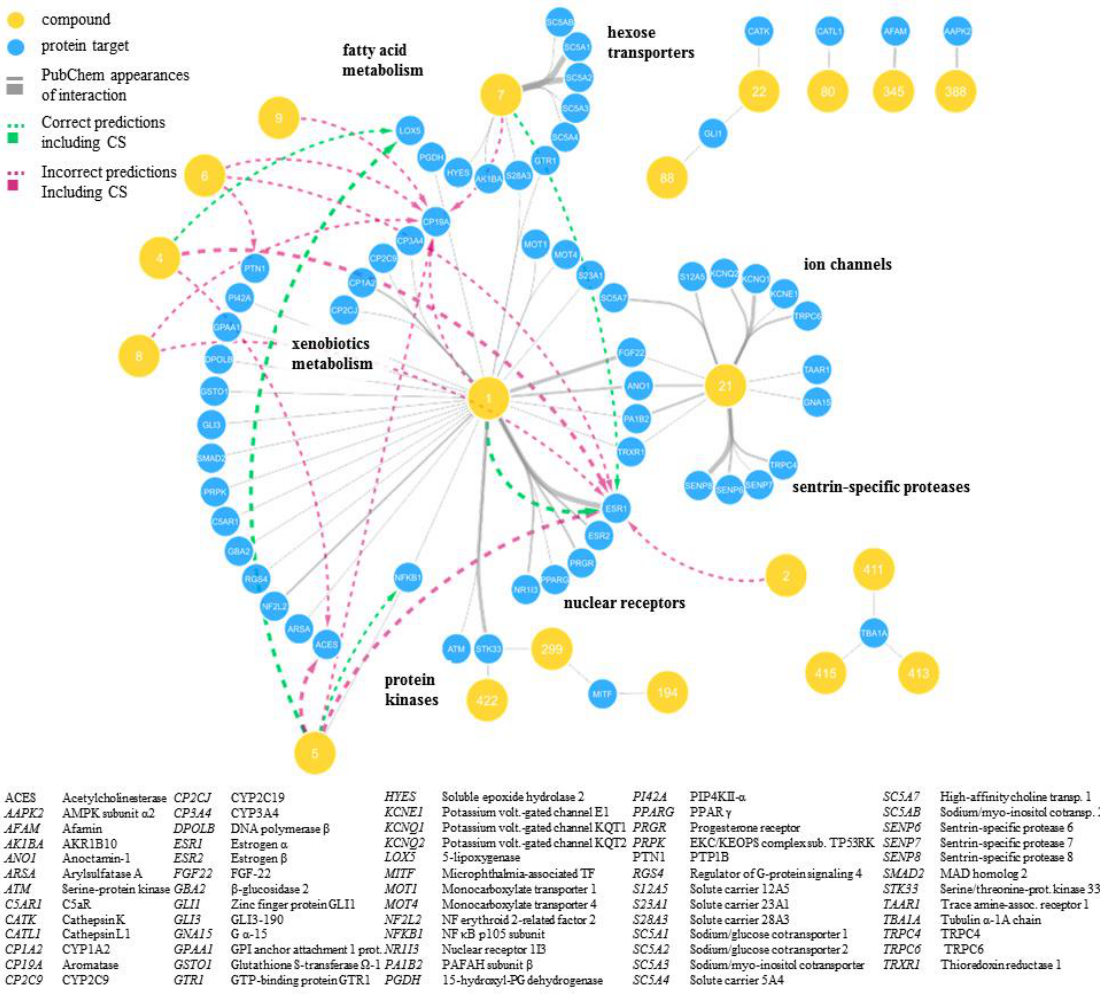
Figure 2. Known DHC biological space illustrated as a network. Shown are only DHCs with interactions reported in PubChem (grey edges), as well as the respective interactions predicted for these compounds (dashed green arrows for correct predictions and dashed magenta arrows for interactions that either proved incorrect in vitro or were not tested). Blue nodes indicate protein targets, and yellow nodes indicate compounds with respective compound numbers. Grey edges indicate known compound-target interactions, while the line thickness is proportional to the interaction weight (see Materials and Methods).